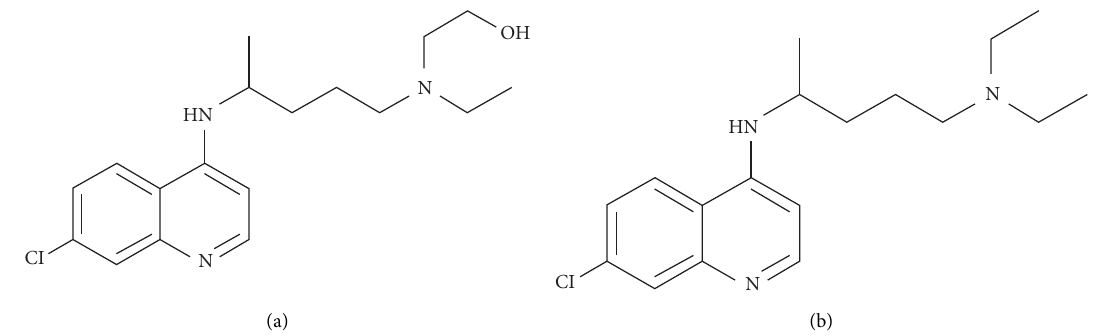
Figure 1: Chemical structure of (a) hydroxychloroquine (HCQ) and (b) chloroquine